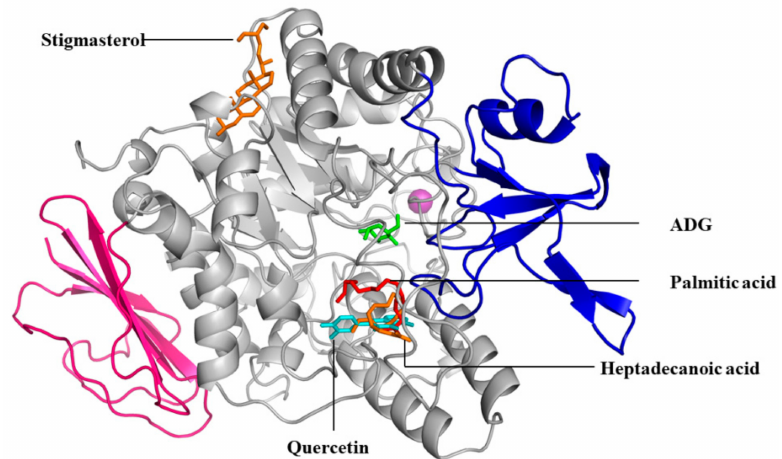
Figure 7. The superimposed 3D diagram showing the binding site of the ADG, Quercetin, Palmitic acid, Heptadecanoic acid and